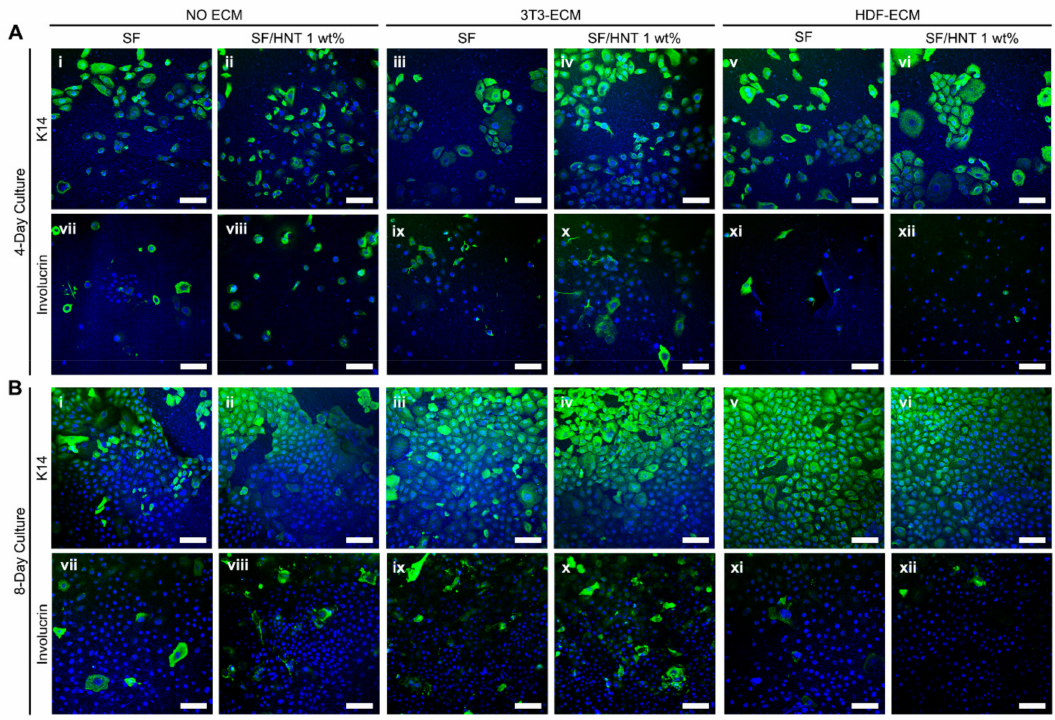
Figure 9. Marker expression of keratinocytes grown on SF and SF/HNT 1 wt% scaffolds. Cytoker- atin 14 (K14) and involucrin expression by keratinocytes grown on the SF-based scaffolds with or without either 3T3 cell or HDF ECM for ( A ) 4 days and ( B ) 8 days. Keratinocytes (0.4 × 10 4 ) were cultured in DKSFM, fixed with 4% paraformaldehyde, and stained with antibodies recognising K14 ( A-i – A-vi , B-i – B-vi ) and involucrin ( A-vii – A-xii , B-vii – B-xii ). DAPI stained nuclei (Blue); scale bar: 50 µ